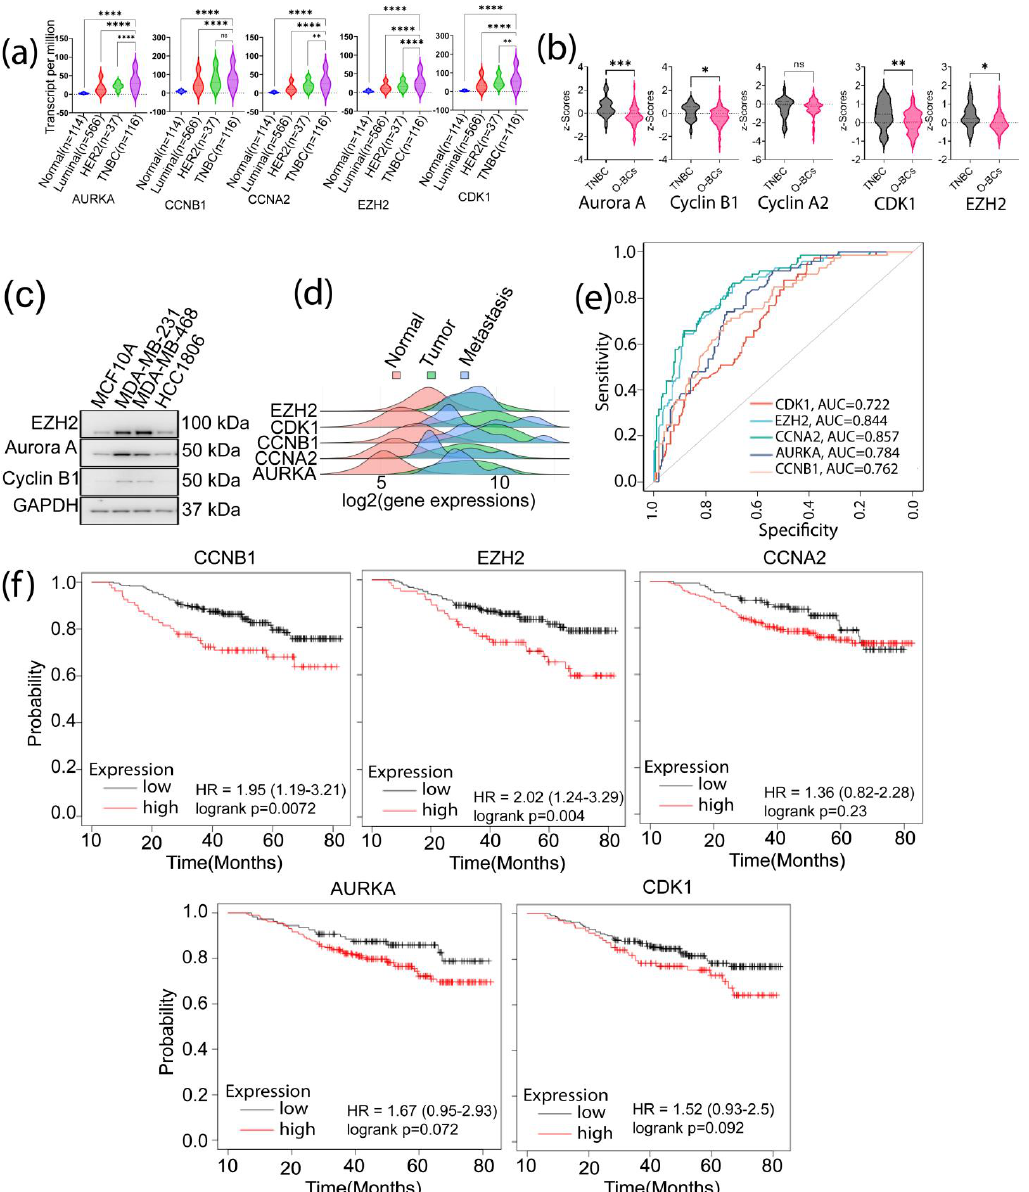
Figure 4. Expression of the five SGs in TNBC, other BCs (O-BCs), and normal samples. ( a ) mRNA expression of the signature genes (SGs) in TNBC, O-BCs and normal samples; ( b ) analysis of